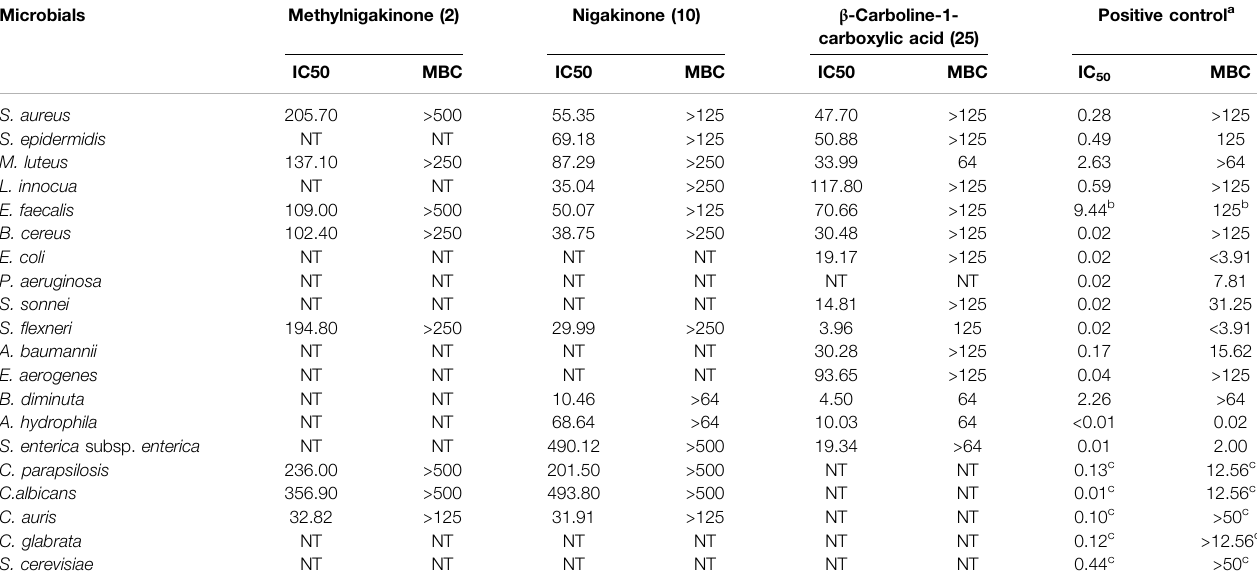
TABLE 3 | Antimicrobial activity ( μ g/ml) of three β -carbolines.